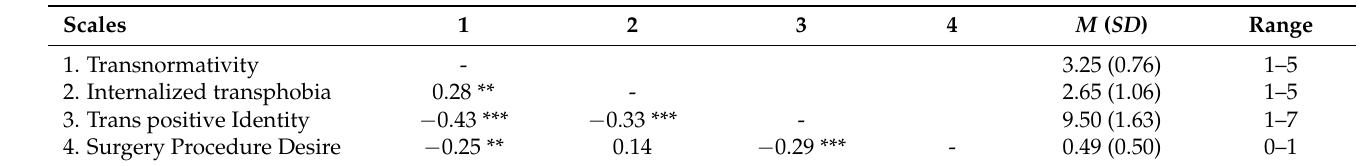
Table 3. Correlations between transnormativity, internalized transphobia, trans-positive identity, and surgery procedures